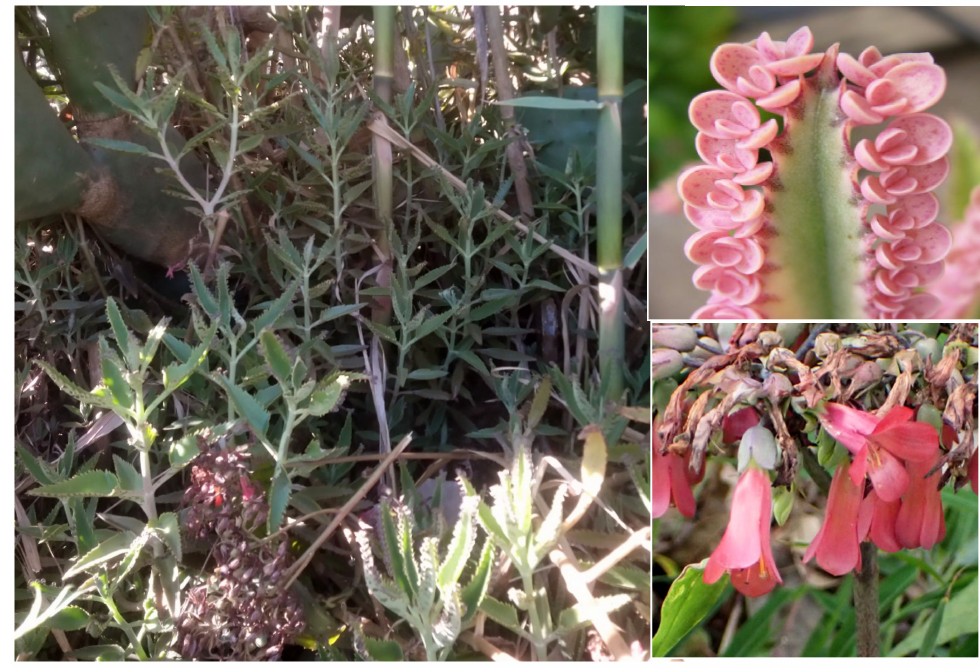
Figure 54. Kalanchoe daigremontiana in Arundo donax community (Caffarella valley). Melia azedarach L. : this species was indicated as doubtfully spontaneous in Atlante della flora vascolare del Lazio [67], whereas it is casual for the region in Italian and Roman floras [9,33]. I here confirm the occurrence of Melia azedarach as casual in Latium, having found individuals in shrubs and forest communities and along paths (Figure 55).